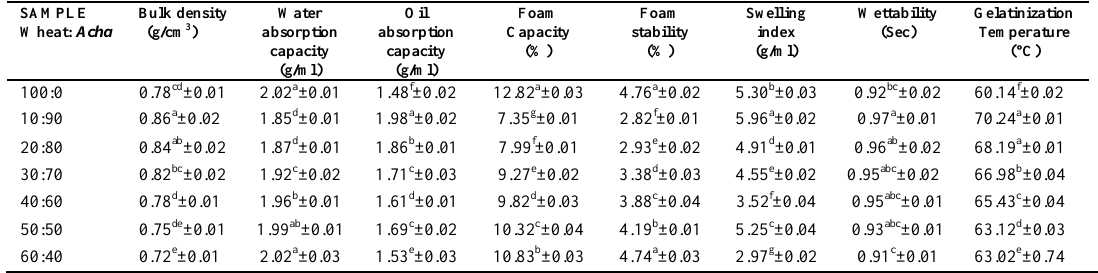
Values are means + standard deviation of duplicate determination. Mean values in the same column with different superscript are significantly different